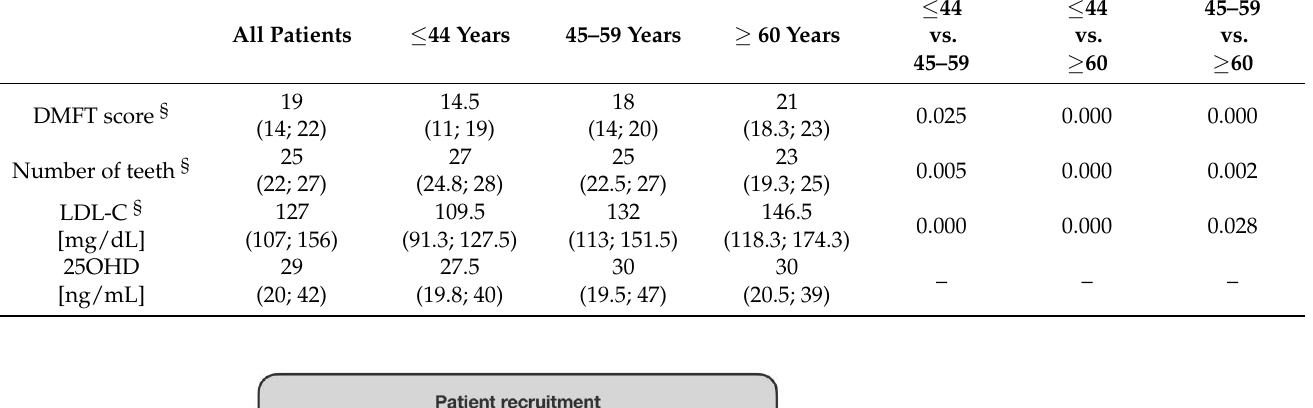
Table 1. Patient characteristics (DMFT score, number of teeth, LDL-C, 25OHD). Depiction of medians (first; third quartiles) and statistically significant differences from pairwise comparisons (Mann– Whitney U tests; α = 0.05).